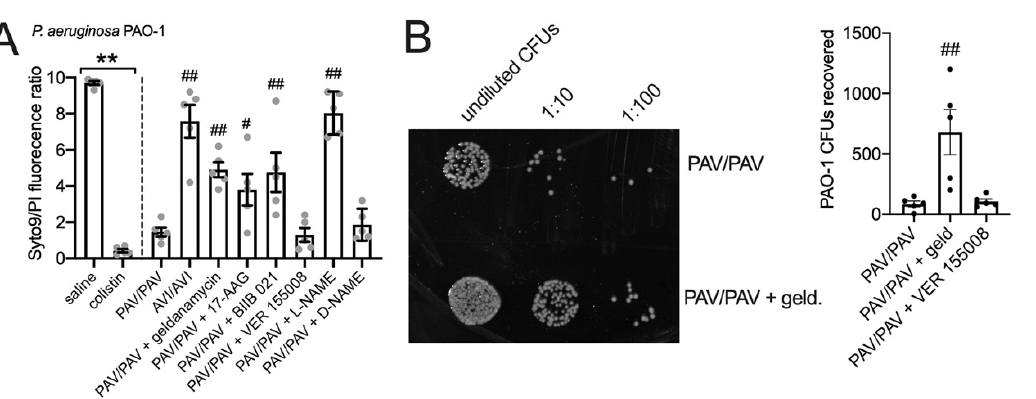
Figure 8. HSP90 inhibition reduces nasal epithelial bacterial killing mediated by T2Rs and NO. P. aeruginosa PAO-1 bacteria were incubated with nasal ALI cultures as described in the methods. ( A ): Bar graph showing live (Syto9)/dead (propidium iodide [PI]) staining quantified by fluorescence plate reader. First two bars represent bacteria incubated in the absence of nasal cells treated with saline only or saline + colistin. This illustrates max (saline) and min (colistin) live/dead ratios. Significance by one way ANOVA with Bonferroni post-test; ** p < 0.01 between bracketed groups; # p < 0.05 and ## p < 0.01 vs. PAV/PAV cultures with no inhibitor. ( B ): Representative image (left) and bar graph (right) showing CFU counts from experiments as shown in ( A ). HSP90 inhibitor geldanamycin reduced bacterial killing (increased CFUs) while HSP70 inhibitor VER 155008 did not. Significance by one-way ANOVA with Dunnett’s post test comparing all values to PAV/PAV control (no inhibitor); ## p < 0.01 vs. PAV/PAV control.